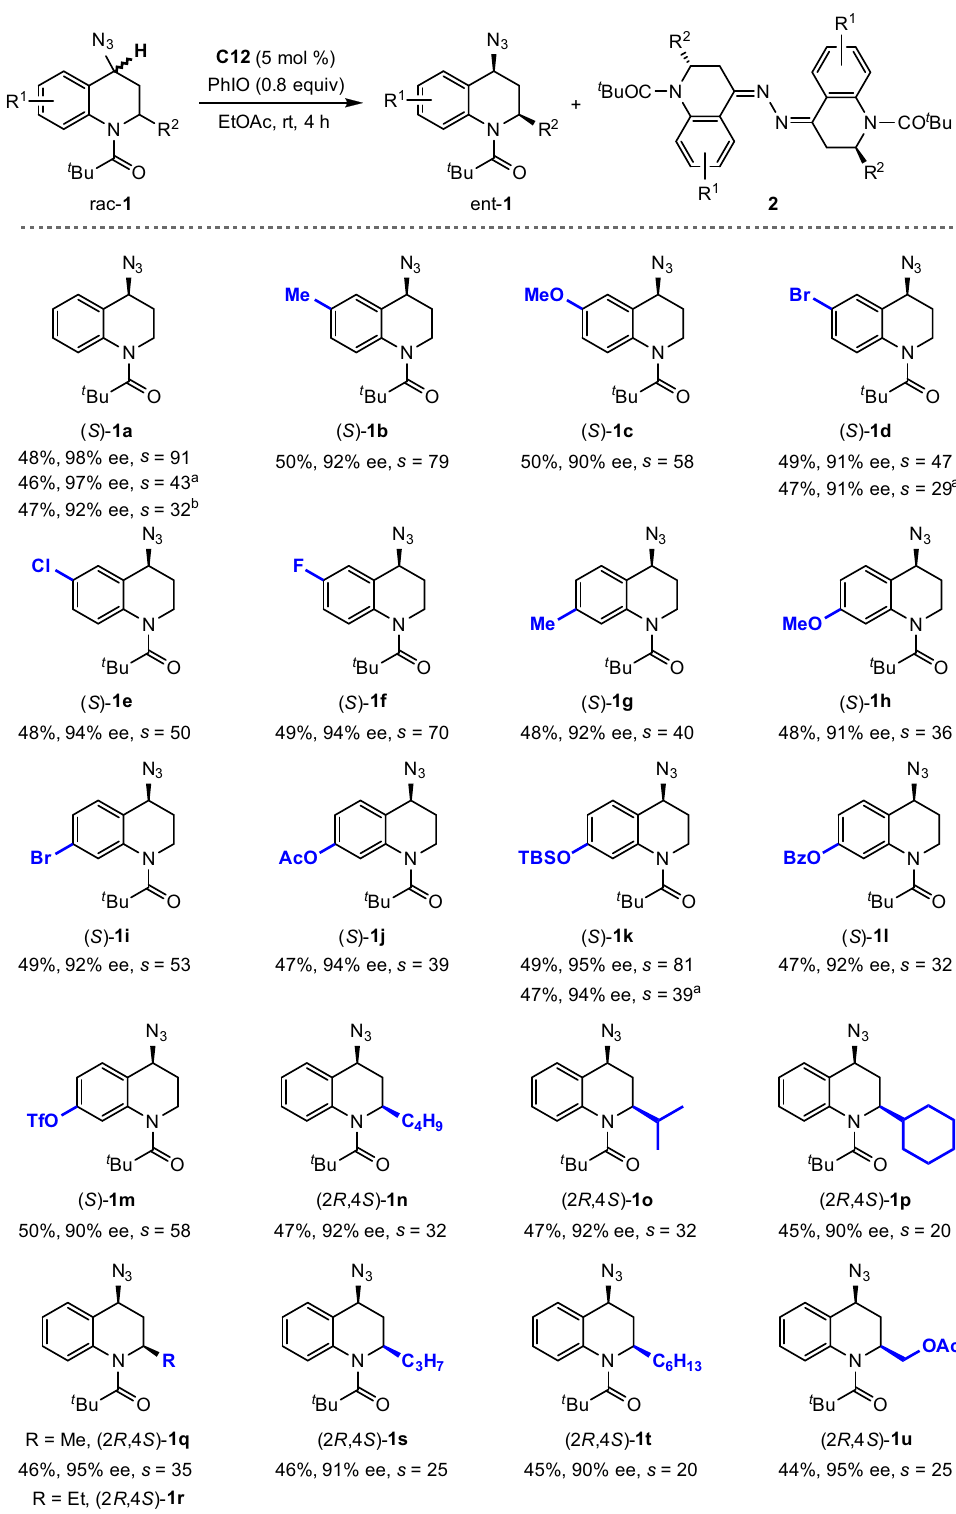
Fig. 2 Kinetic resolution of THQ-based organic azides. Conditions: rac- 1 (0.1 mmol), PhIO (0.08 mmol, addition as 8 portions in 30-min intervals over 3.5 h), and C12 (5 mol%) in ethyl acetate (1.0 ml) at rt for 4 h. a Reaction with 0.5 mmol rac- 1 . b Reaction with 1.0 gram of rac- 1 .